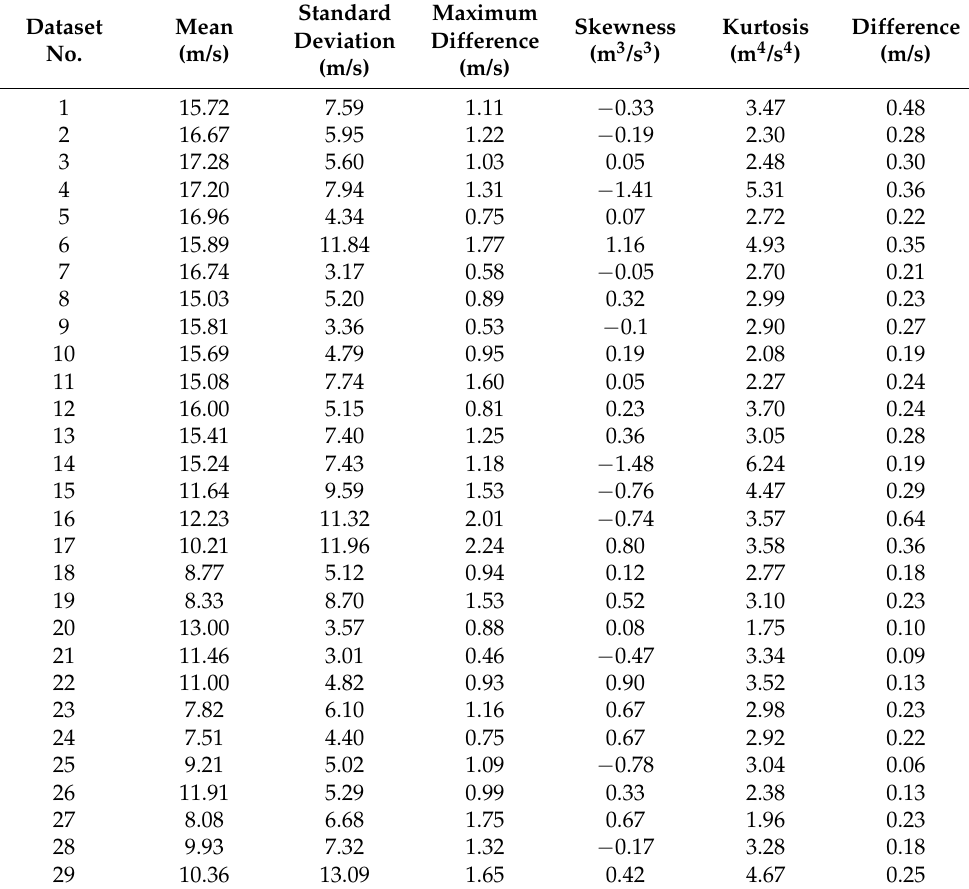
Table 1. Characteristic values of 29 wind speed